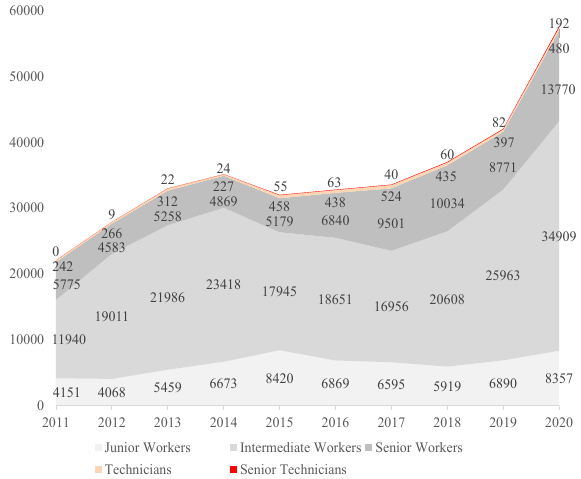
Figure 1. The number of skilled talents obtained the qualifications in the past